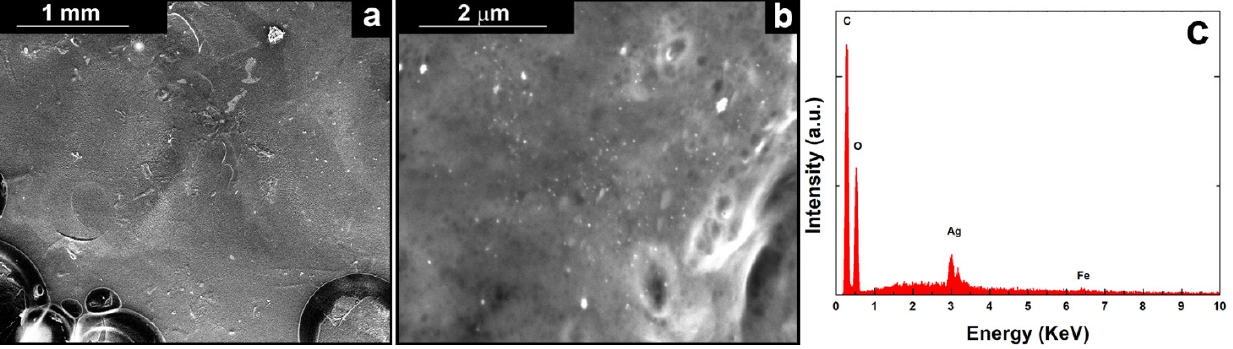
Figure 4. XRD patterns of the samples: ( a ) before and ( b ) after aging in SBF. The presence of silver was confirmed by the peak at 2 θ equal to 38.07 (characteristic of (111) diffraction plane). This peak is of a very low intensity due to the low concentration of Ag, and also very wide as Ag is present as nanoparticles and therefore it is characterized by an extremely small average grain size. The secondary characteristic peak of silver at 2 θ equal to 44.43° is not visible due to the overlap with the signal coming from the metal substrate that is predominant. In comparison with bare steel, in the samples the peaks of metallic substrate appear with less intensity, mainly for those obtained using a deposition solution of 10gL − 1 CS. This is due to the presence of coating that shields the steel diffraction peaks. In Figure 4b the diffraction pattern of the sample obtained using a solution with 7.5 gL − 1 CS/AgNPs after 21 days of aging in SBF was reported. For a better comparison also the patterns of bare AISI 304L and the coating before aging was reported. The comparison highlights important results. The first concerns the disappearance of diffraction peak of the silver due to the release of AgNPs in SBF. This result is in line with EDS analysis as